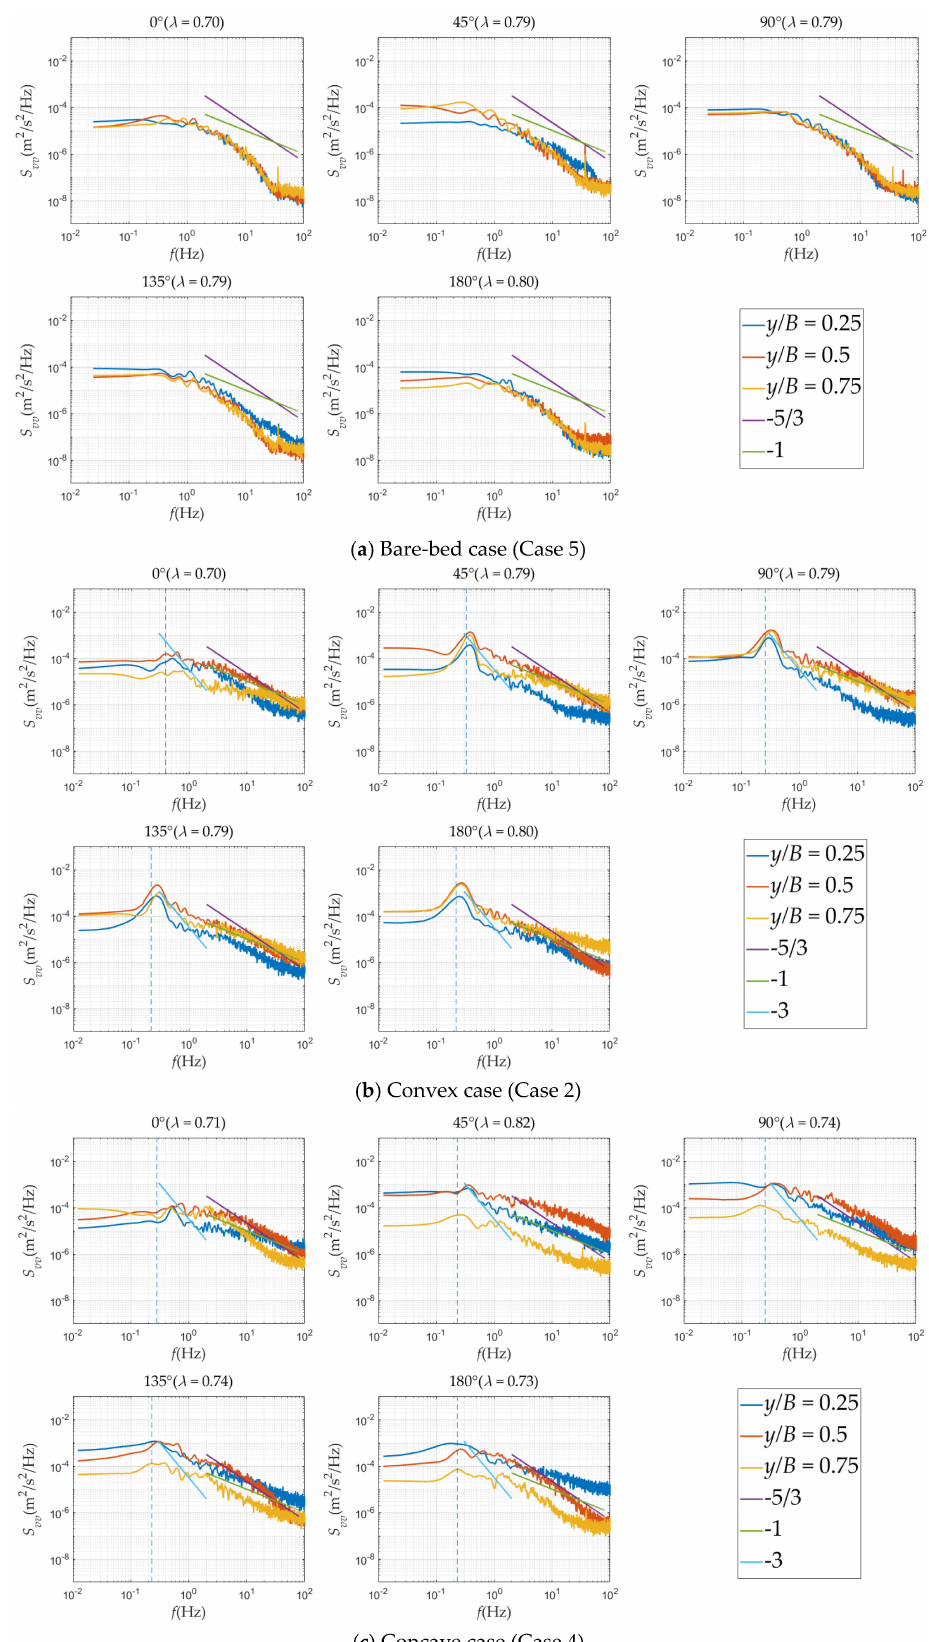
Figure 8. PSD at different sections of convex and concave